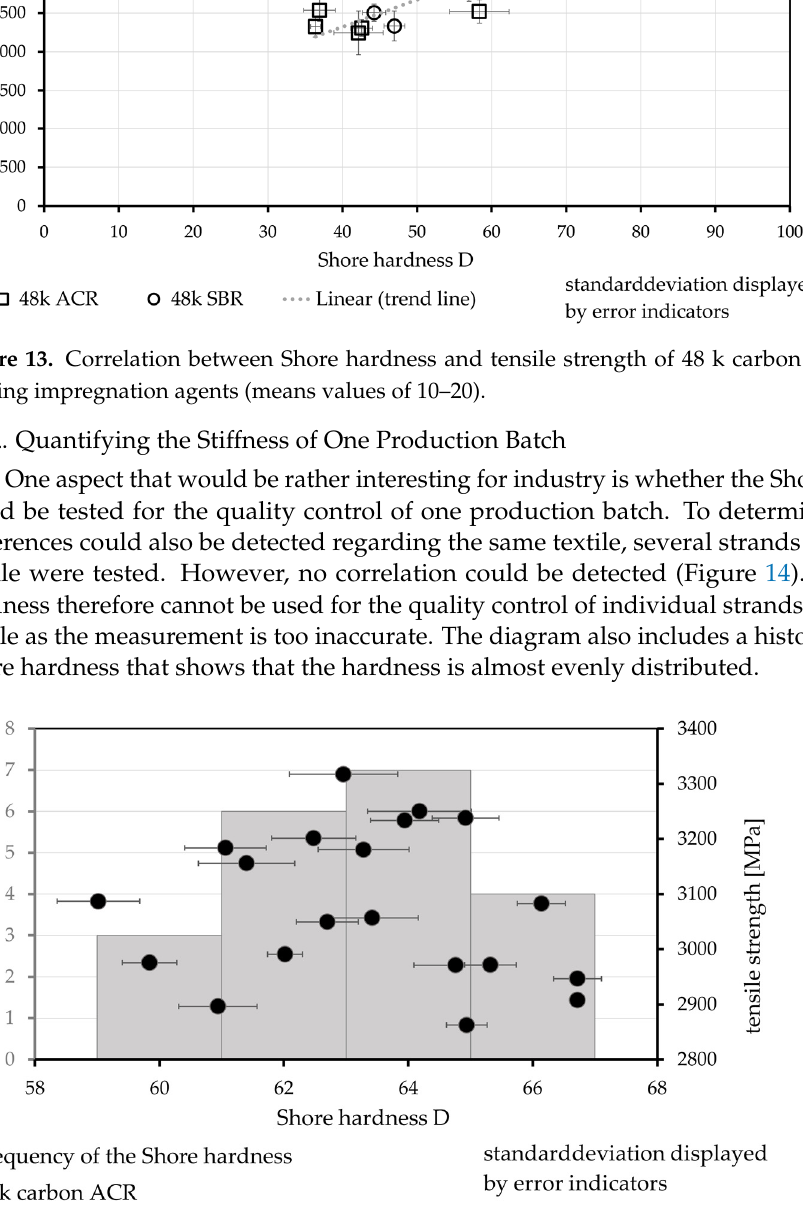
Figure 14. Shore hardness and tensile strength of one production batch and histogram of Shore hardness (means: 10–20).